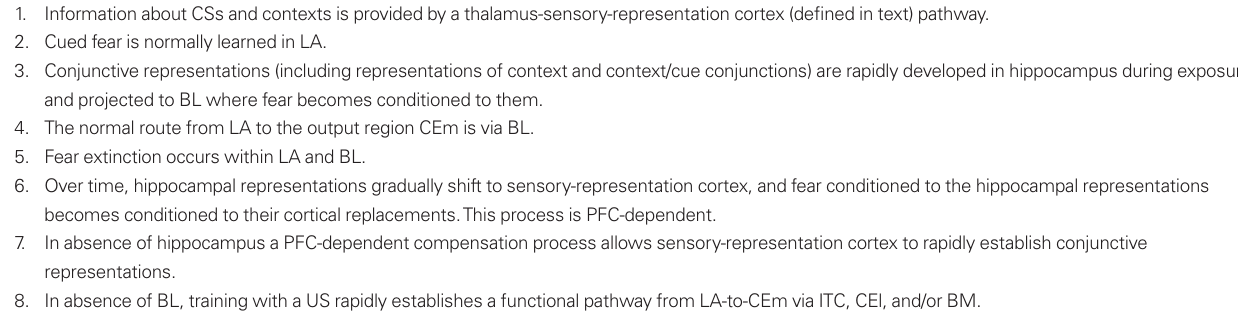
Table 2 | summary of main